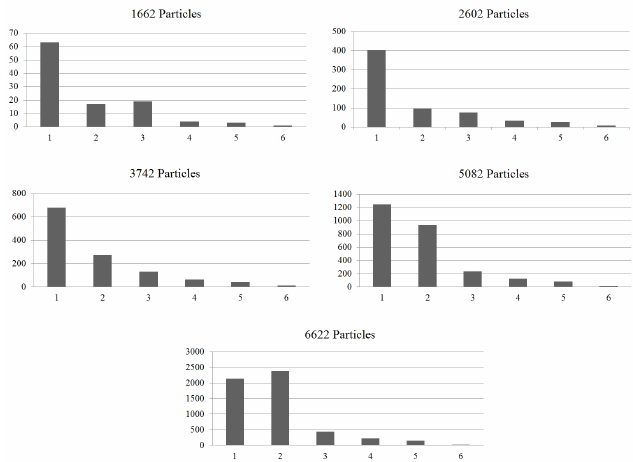
Fig. 15: Execution time in milliseconds of each function for each test case on GPU